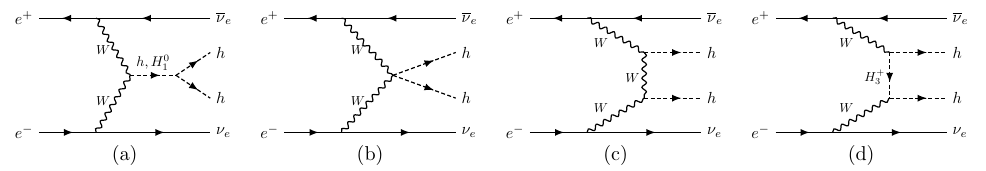
(cid:0) colliders.